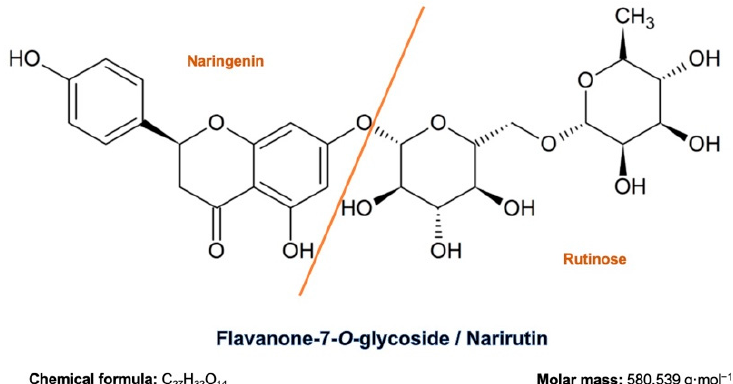
Figure 1. Narirutin chemical structure, formula and molar mass.